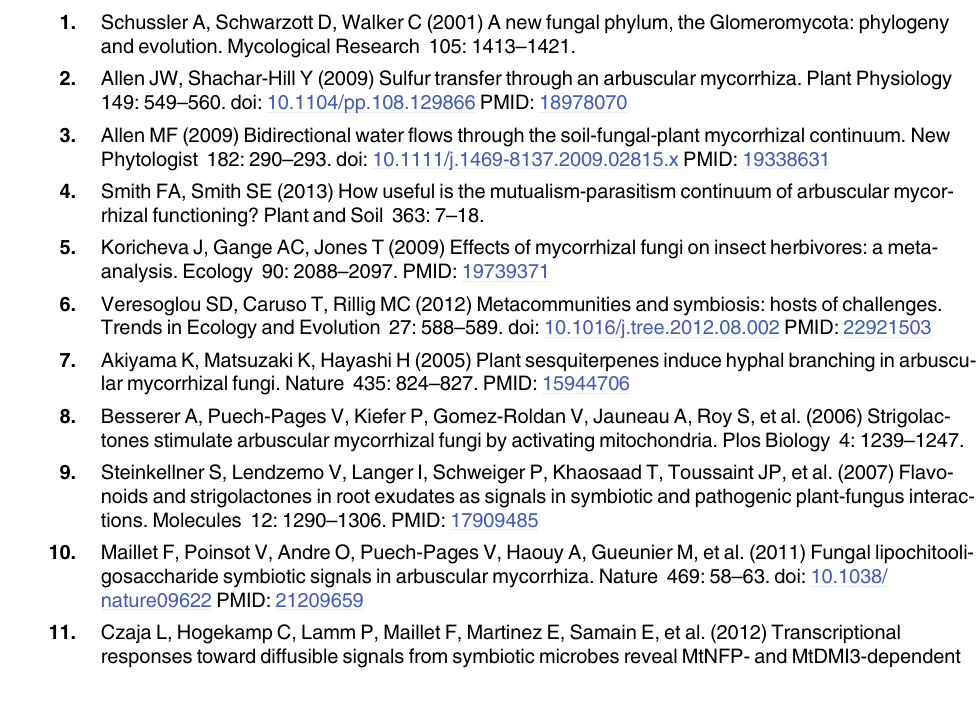
S1 Table. Summarizing table characterizing the SuperSAGE Tags used in this study. S2 Table. Similar putative function of significantly up-regulated annotated plant genes overlapping in the present study, the study of Ruzicka et al.(2013) [63] with S . lycopersicum and the study of Hogekamp et al. (2011) [29] with M . truncatula . Putative functions found in all three studies (A), and in only two of the studies (B, C). The datasets contained the most highly up-regulated genes and their function for N . attenuata (log2 fold change > 2, P < 0.05, 301 mapped and annotated Tags), AMF-infected tomato ( P < 0.05, log2 fold change > 2, 977 contigs, [68]), and Medicago roots log2 fold change > 2, 394 gene IDs [29]). S3 Table. Similar putative functions of annotated fungal tags and contigs significantly up- regulated after AMF infection found in the present study in N . attenuata and in tomato [68] (log2 fold change > 2, p <